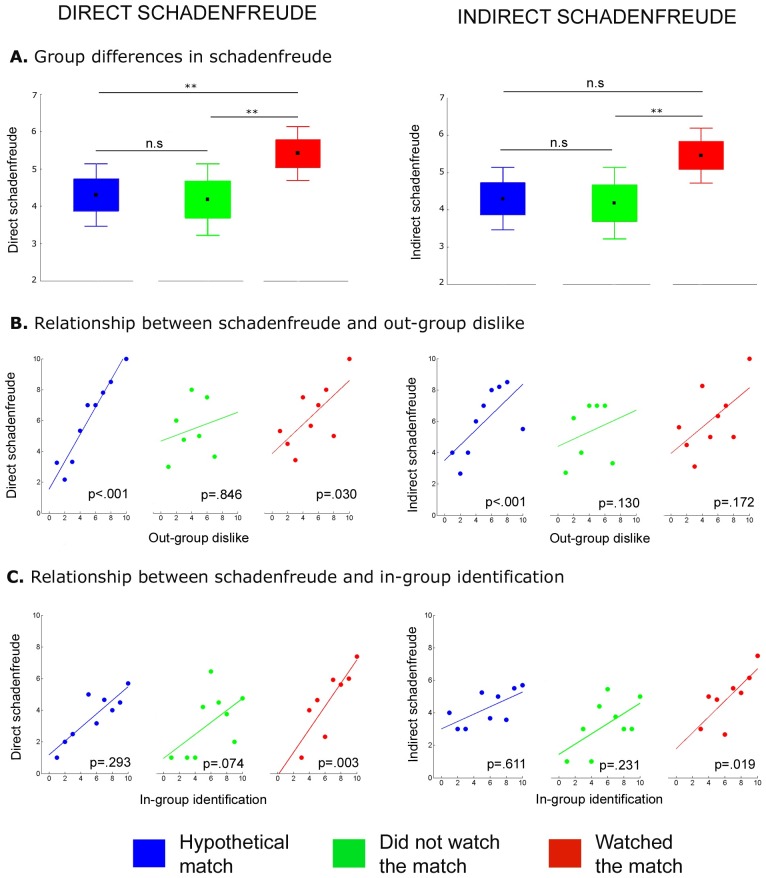
Group comparison in schadenfreude and its predictors.A. Box plots depict differences in direct and indirect schadenfreude between participants who completed the survey in the hypothetical match (blue), those that answered after the real game but did not watch it (green), and the group that watched the match (red). Black points represent the means, boxes the SE, and whiskers ±1.96*SE. Asterisks show significant differences between groups (p < .05). B. Scatter plots show the association between schadenfreude and the degree of out-group dislike in each group. C. Scatter plots show the relationship between schadenfreude and the degree of in-group identification in each group.